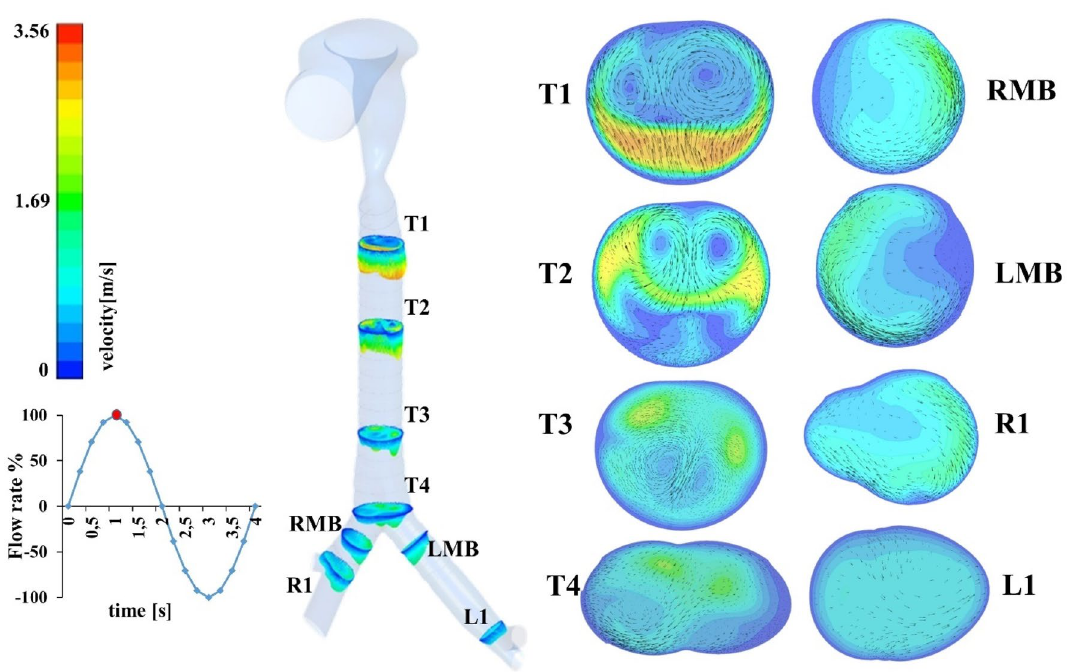
Figure 2. Development of the velocity field downstream the trachea at t = 1 s, in terms of velocity magnitude and tangential component of the velocity vectors. In evidence the rotational flow on the plane of proximal trachea, decreasing in the distal section down through the bifurcation. (Fluent v16, CFD-Post v16-Ansys, www. ansys